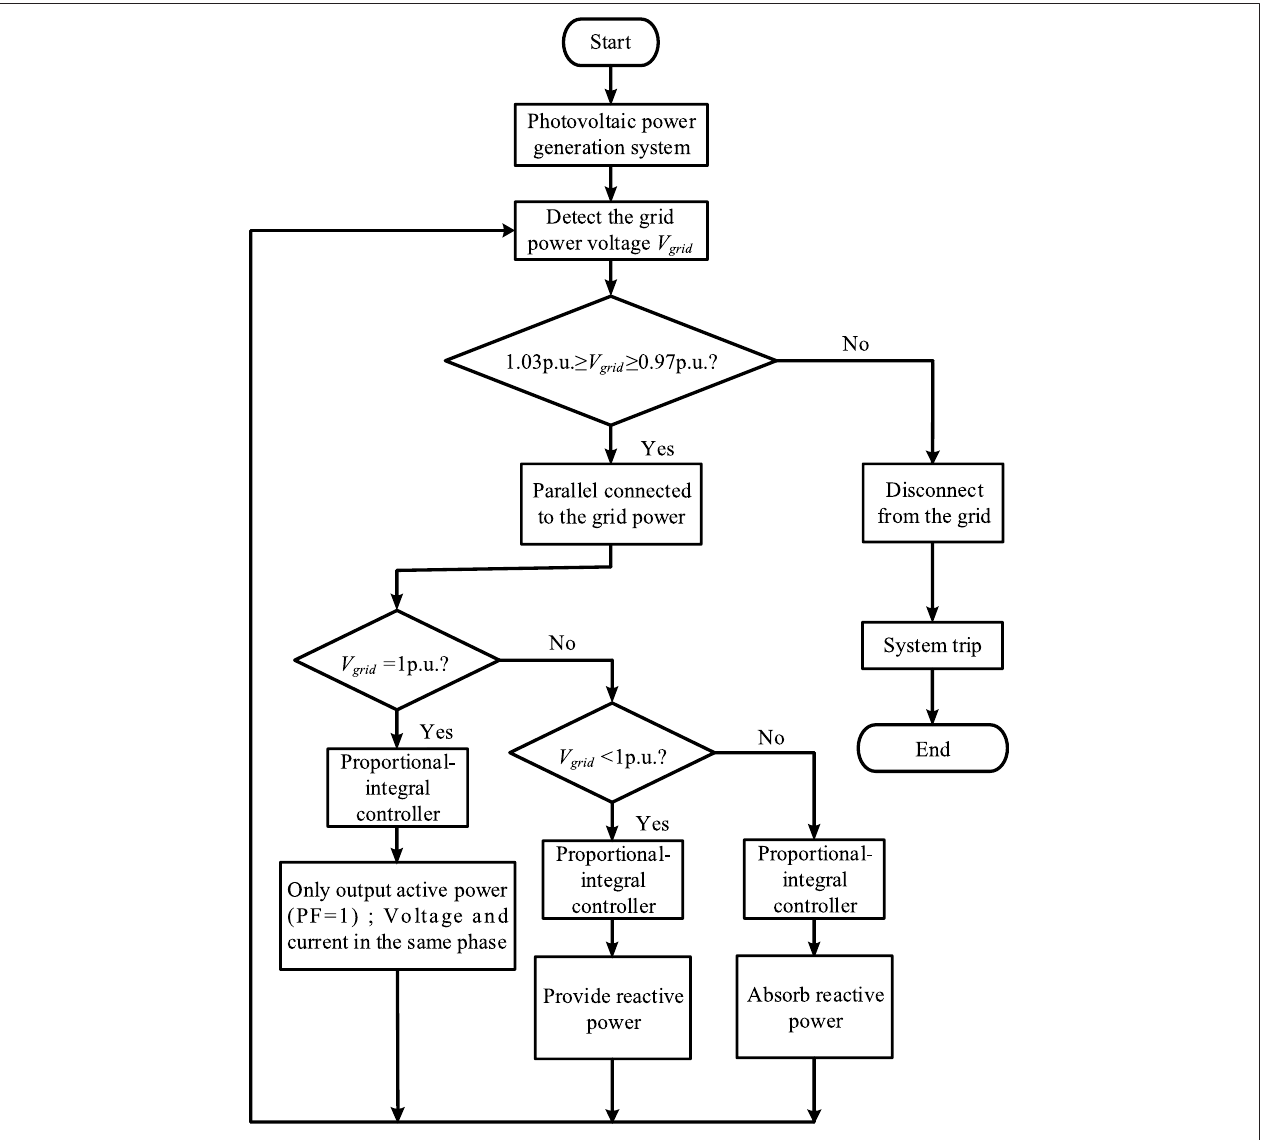
FIGURE 7 | Voltage-power control fl